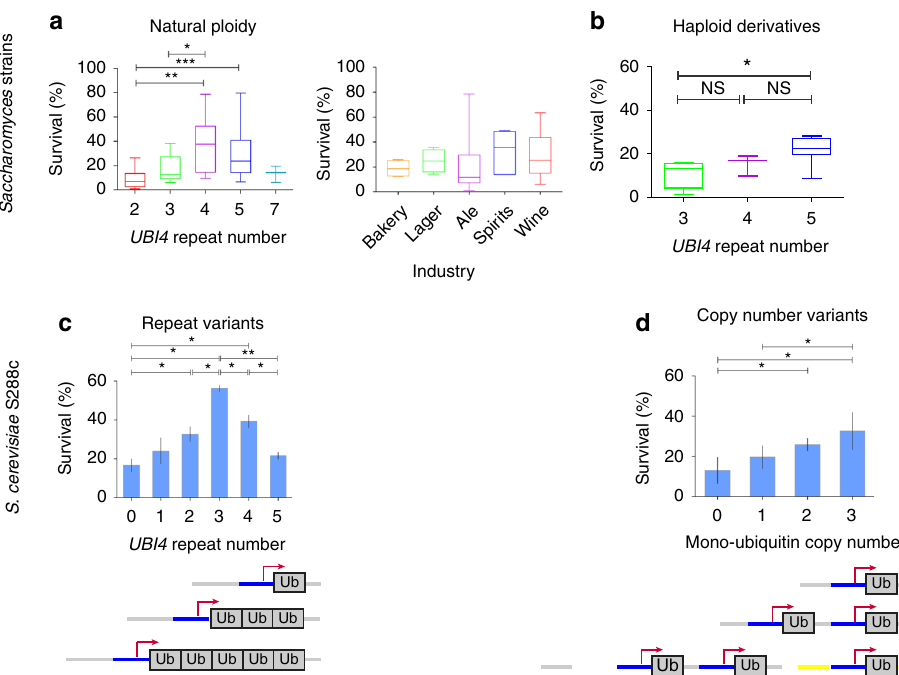
Fig. 2 UBI4 repeat number in fl uences survival after heat shock in natural and engineered Saccharomyces strains. a Survival of 65 diverse Saccharomyces strains after heat shock (43 °C, 4 h) is in fl uenced by the number of ubiquitin units in their UBI4 gene, and not their industrial niches (right panel). The strains designated as having a UBI4 gene of 4 or 5 repeats used in this experiment were all homozygous for the UBI4 gene; strains designated as having 2 or 3 UBI4 repeats were heterozygous for the UBI4 gene, with the other allele having 4 or more repeats. b Survival levels of haploid derivatives of industrial and feral S. cerevisiae strains increase with their UBI4 repeat number. It should be noted that no haploid strains with a repeat number over 5 were available. c Survival after heat shock (44 °C, 4 h) of haploid isogenic S. cerevisiae S288c variants containing different numbers of UBI4 repeats. The scheme shows the UBI4 gene structure in these repeat variants. Data points represent mean ± SD; n = 3. d Heat shock survival of isogenic S. cerevisiae strains containing multiple copies of a mono-unit UBI4 gene (i.e., encoding only one ubiquitin unit) correlates with the total number of ubiquitin-coding units. The scheme shows the structure of the mono-ubiquitin copy number variants. The fi rst two copies were inserted in tandem (at the UBI4 gene locus), whereas the third unit (depicted by the yellow overhangs) was inserted in a neutral genomic location. Data points represent mean ± SD; n = 4 or 6. Statistical signi fi cance was assessed using the Mann – Whitney test ( a , b ) or an unpaired t -test (with Welch ’ s correction) ( c , d ). NS, not signi fi cant ( P > 0.05), * P < 0.05, ** P < 0.01, *** P < 0.001. For the sake of clarity, only signi fi cant differences in survival are